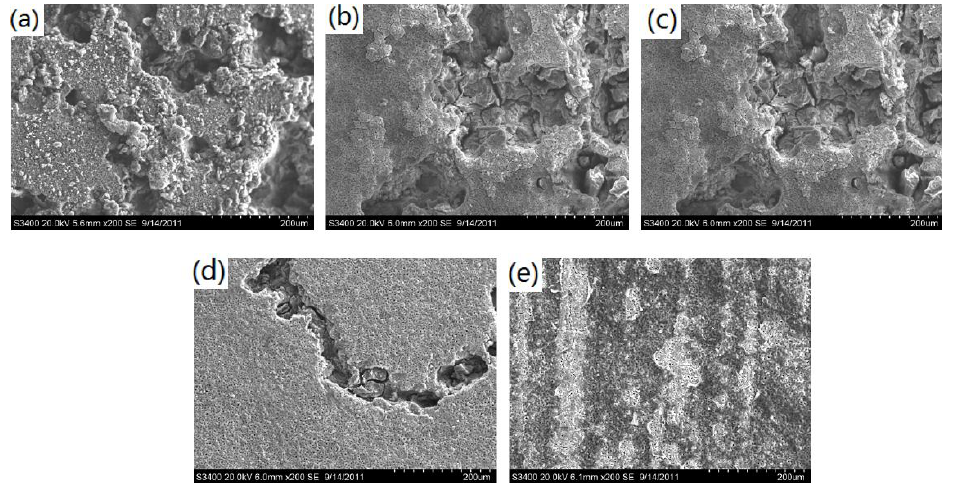
Figure 6. SEM morphologies of the broken MAO coatings on the as-cast and ECAPed AZ91D samples immersed in 3.5 wt % NaCl solution for 4 days: ( a ) as-cast; ( b ) 4 passes; ( c ) 8 passes; ( d ) 12 passes and ( e ) 16 passes.